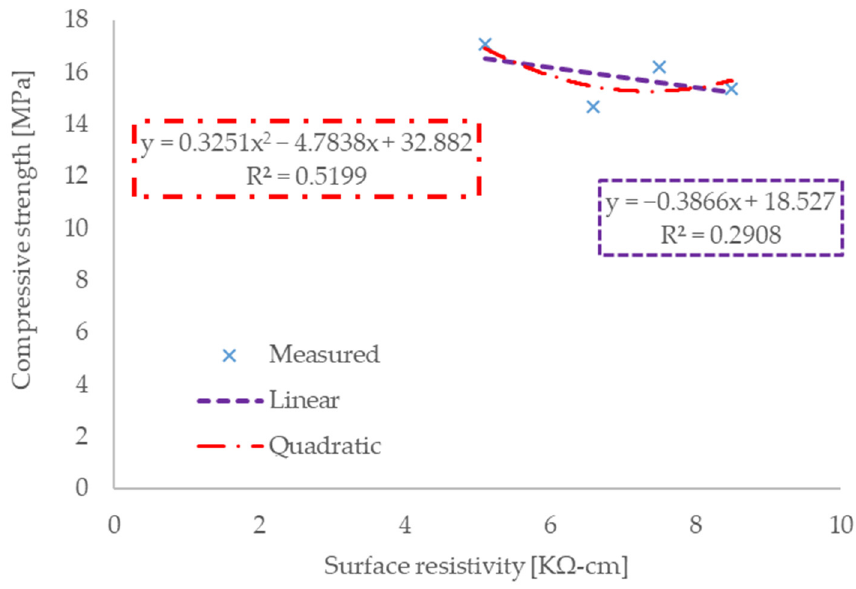
Figure 8. The relationship between surface resistivity and compressive strength.